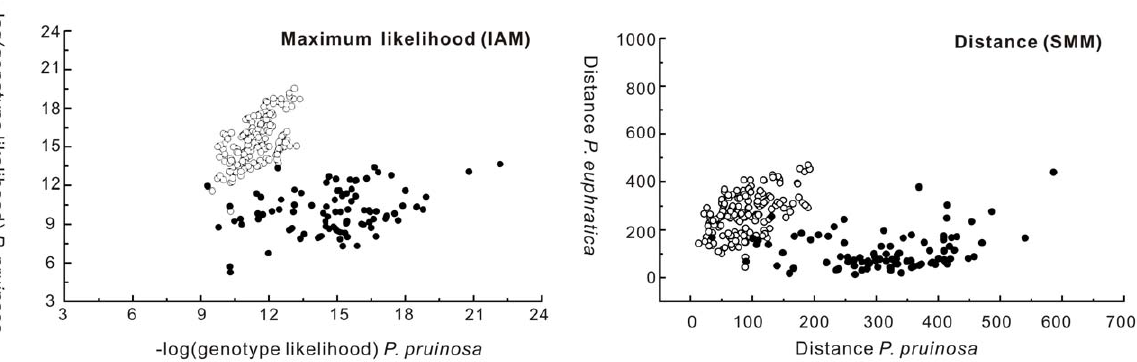
Figure 3. Individual assignment based on maximum likelihood analyses of nuclear SSR alleles. The methods were based on allele frequencies under an infinite alleles model (IAM) (left) and a distance method (right) using differences in microsatellite allele lengths under a stepwise mutation model (SMM). The filled dots represent P. pruinosa , and the open circles P. euphratica .